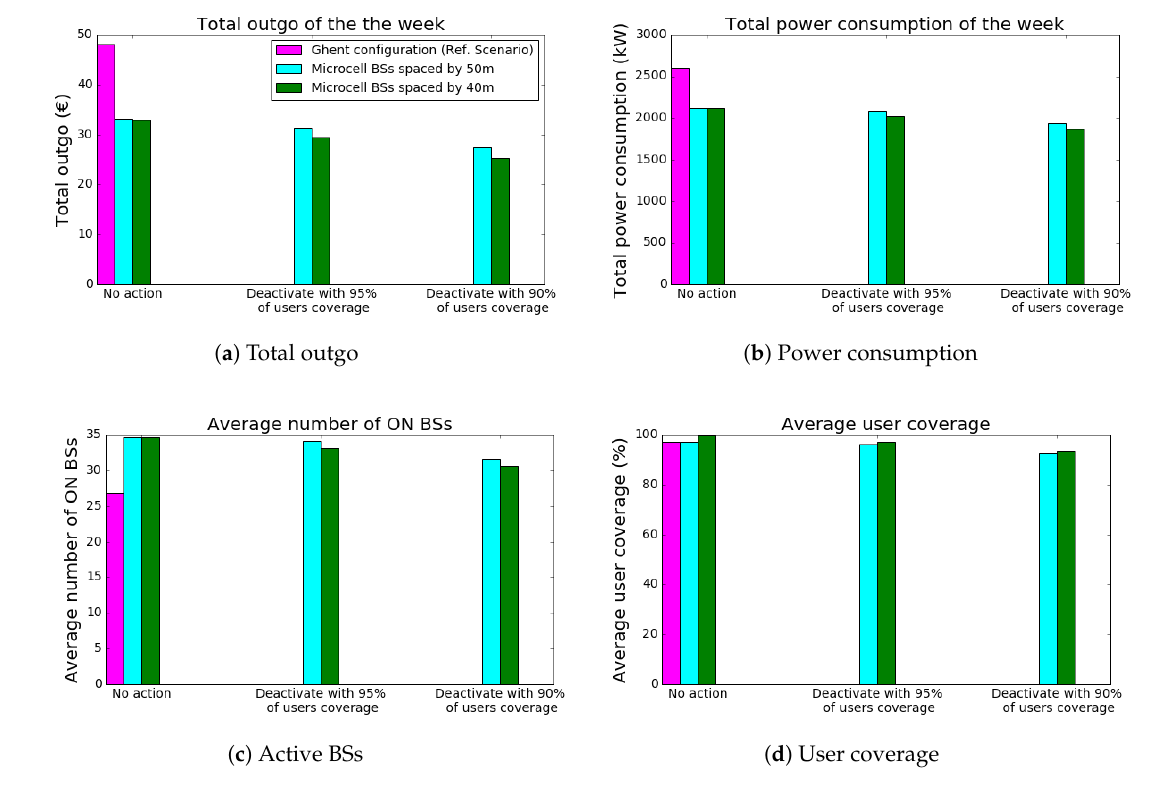
Figure 15. Results obtained with microcell BS